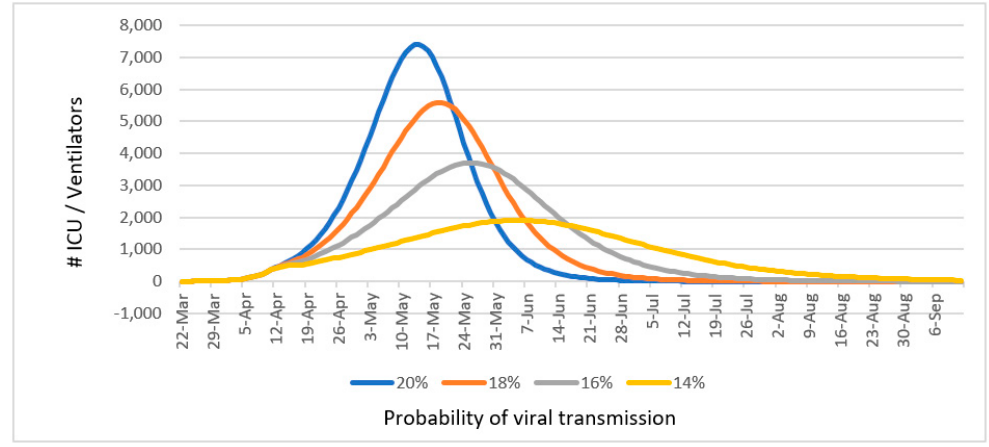
Figure 6. Projected intensive care unit (ICU) and mechanical ventilator needs based on different probabilities of viral transmission (14%, 16%, 18%, and 20%).